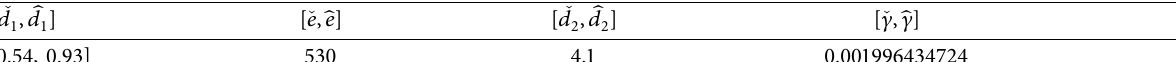
Table 4: Parameters set in subsection 4.2.